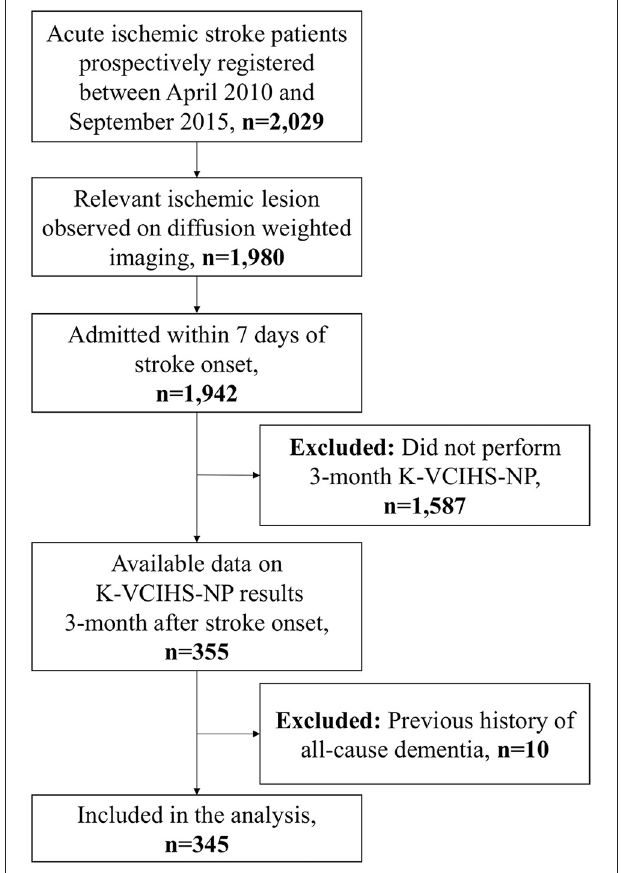
FIGURE 1 | The study